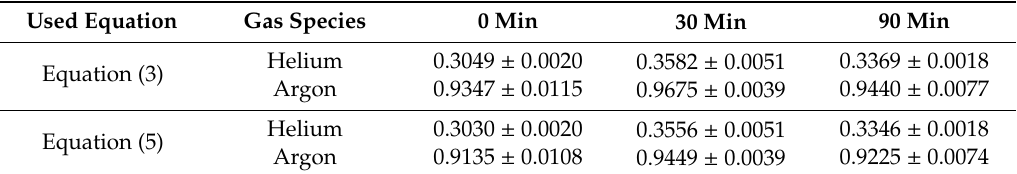
Table 1. A table of the measured energy accommodation coe ffi cient (EAC) with the standard error on 0 min, 30 min and 90 min sample surfaces for helium and